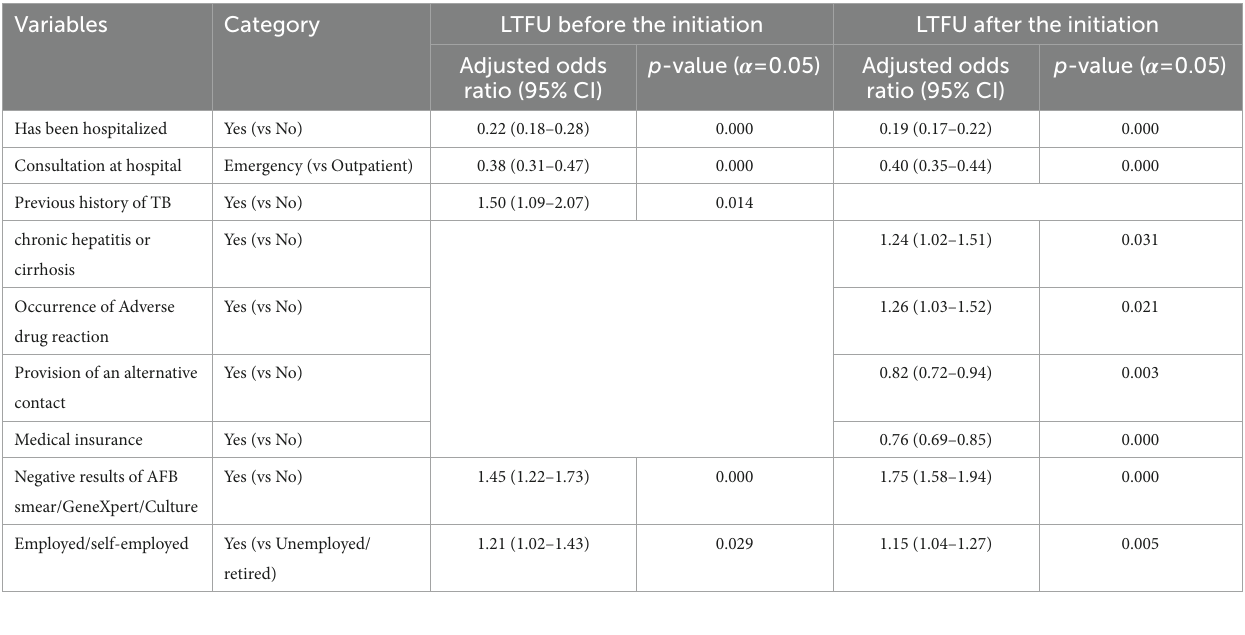
TABLE 3 The adjusted odds ratio of factors associated with loss to follow-up (LTFU) before and after treatment initiation among patients with tuberculosis ( n = 24,265).